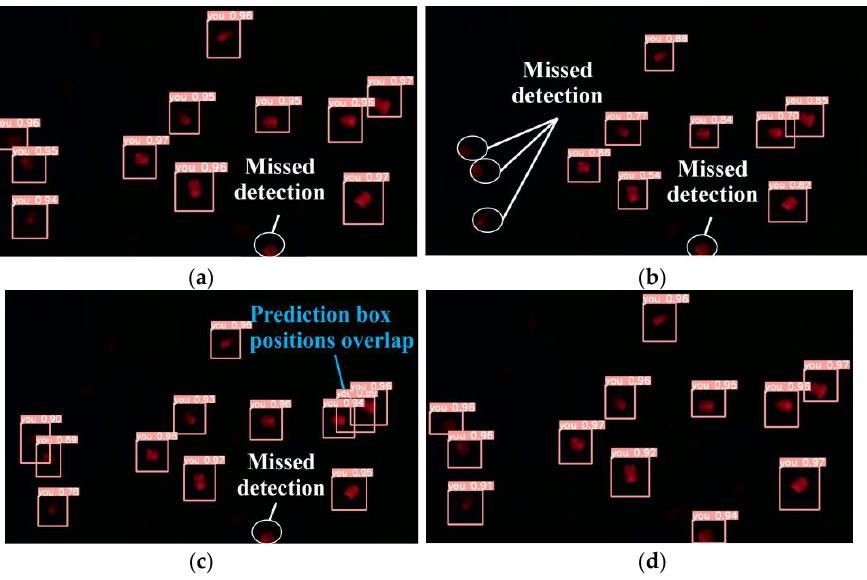
Figure 10. Detection results of the different models: ( a ) Fast R-CNN, ( b ) YOLOv3, ( c ) YOLOv5s, and ( d ) improved YOLOv5s models.